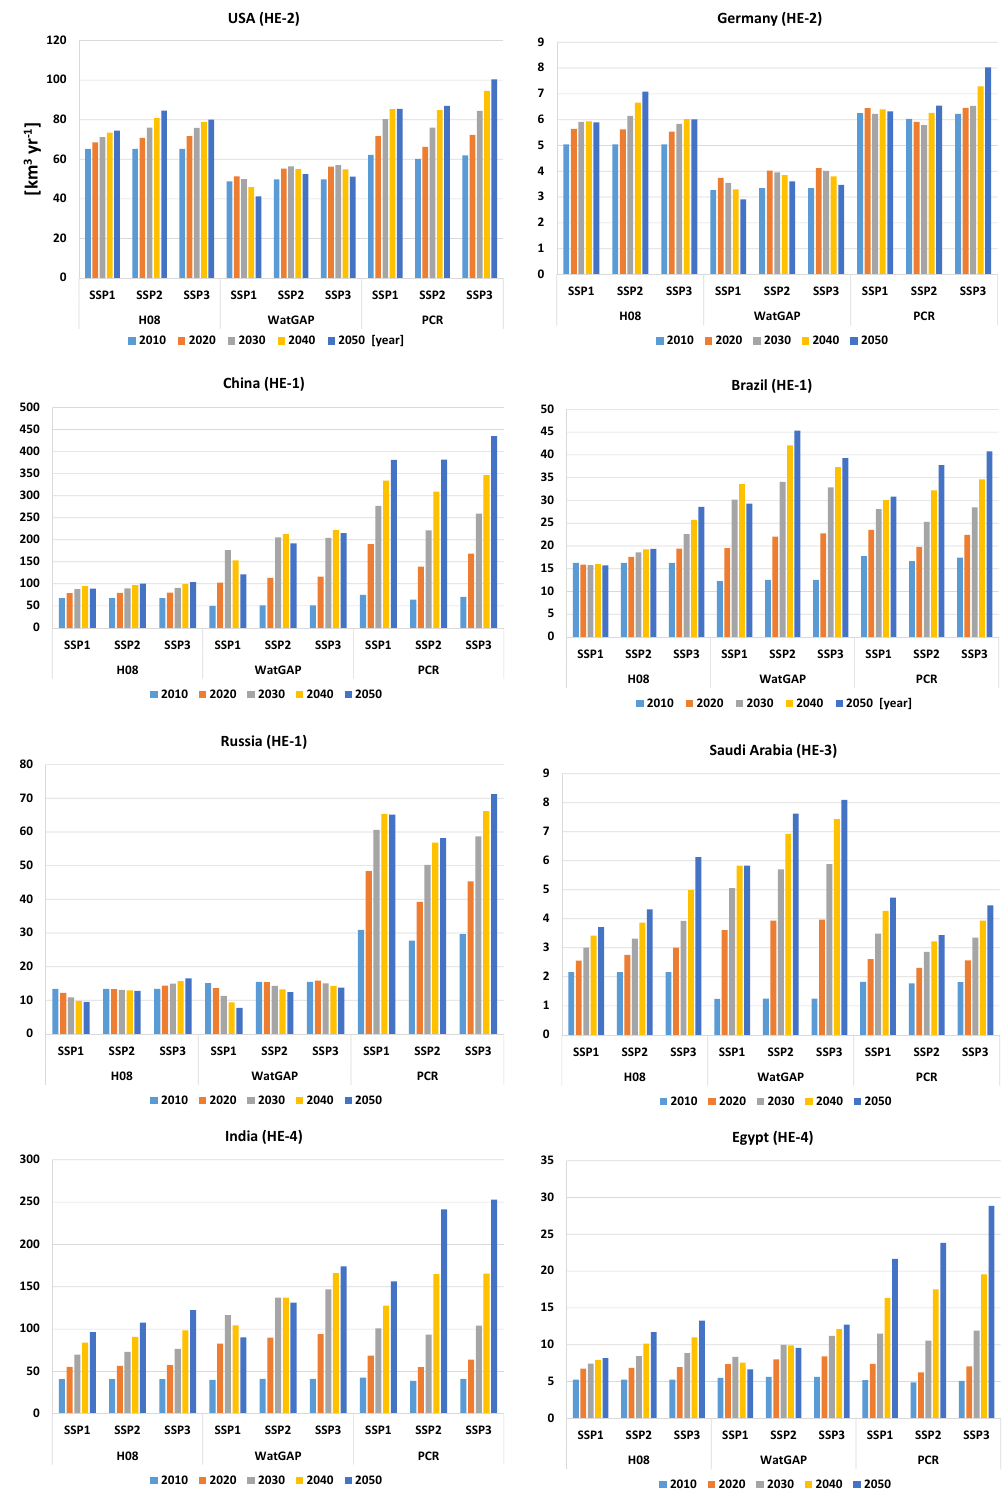
Figure 5. Domestic water withdrawal projections for selected countries calculated by the global water models H08, WaterGAP (WatGAP), and PCR-GLOBWB (PCR) for the years 2010, 2020, 2030, 2040, and 2050, respectively, under three SSP scenarios (SSP1, SSP2, and SSP3). HE denotes the hydro-economic classification (see Appendix